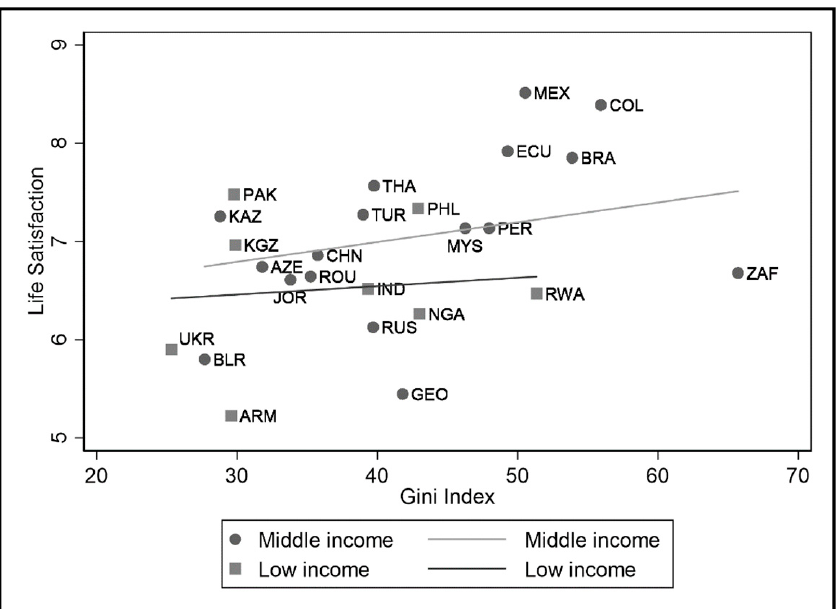
Figure 1. Life Satisfaction versus Gini index, source: authors’ calculation, abbreviation for countries available in Table A2.